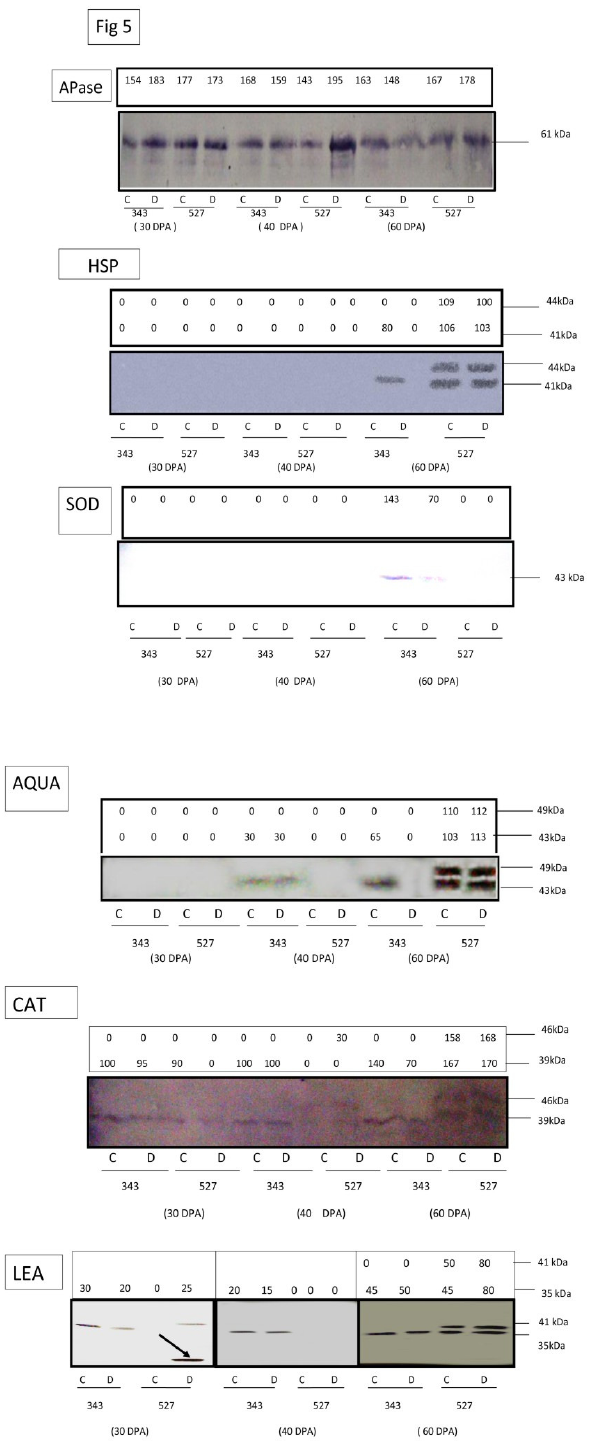
Fig. 5: Immuno-blot analysis of boiling soluble proteins in seeds of drought tolerant (‘PBW 527 ’ ) and drought sensitive (‘PBW 343 ’ ) cultivars of T. aestivum at three different stages (30, 40 and 60 DPA) under control (C) and drought (D) conditions. Numerical values as shown in the top of panels indicates relative band intensities which were determined using Gel visualisation, Documentation and Analysis system (Bio- Rad,USA). Arrow shows the presence of differential